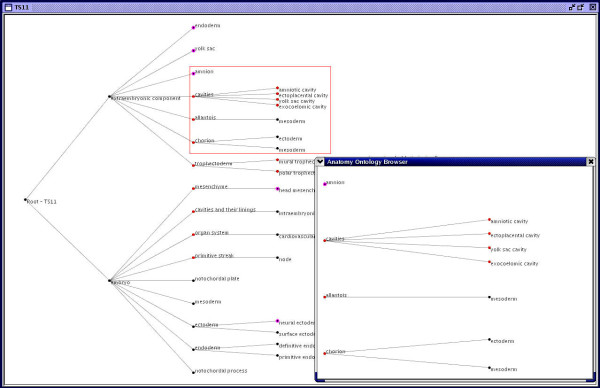
Zooming into a selection area using a sub-window. The selection area in the main window is redrawn in a sub-window, providing magnification by drawing the same number of nodes in a larger area.